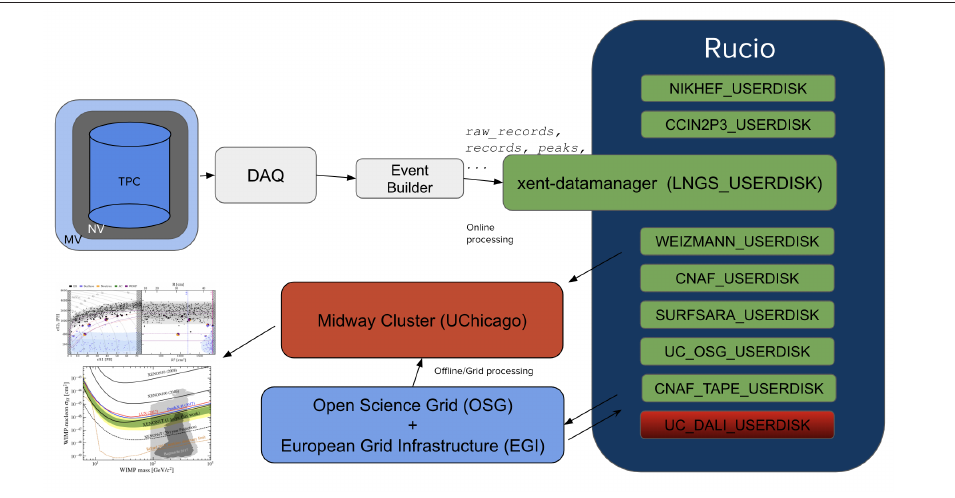
Figure 3. Data management workflow for XENONnT. The introduction of STRAX / STRAXEN for the on-line processing chain of the raw data accelerates the path to the Midway HPC resource and minimizes the need for Grid processing on OSG and EGI